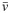
Scaling.
v¯ plotted against A02f0 for DDM measurements of thawed straws: BB (□), CH (△) and HO semen (○) were pipetted undiluted into pre-warmed sample chambers (≈ 80 × 106cells/ml) and movies (2×, 300 fps, 300 p, 40 s) were recorded immediately after filling every 2min subsequently. (Only the first 30 min of CH are included, before the data becomes noisy.) Data from Figs 6 and 7 and Table 1 plotted in (*). Grey area defines the range of linear fit through the origin for all three datasets and v¯⪆50μms-1.